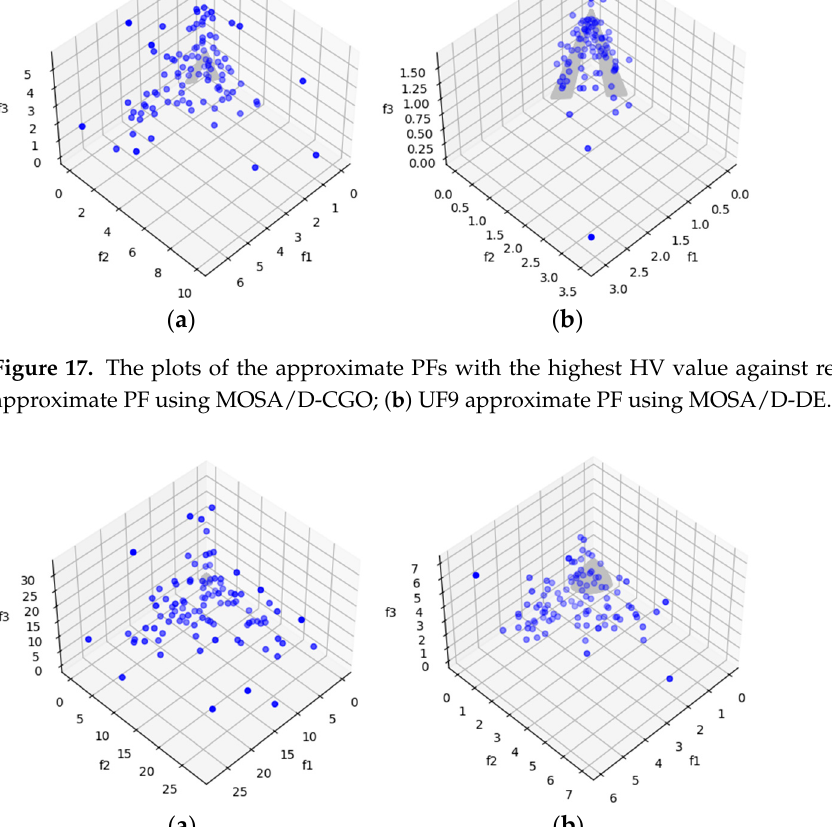
Figure 17. The plots of the approximate PFs with the highest HV value against real PF. ( a ) UF10 approximate PF using MOSA/D-CGO; ( b ) UF10 approximate PF using MOSA/D-DE.